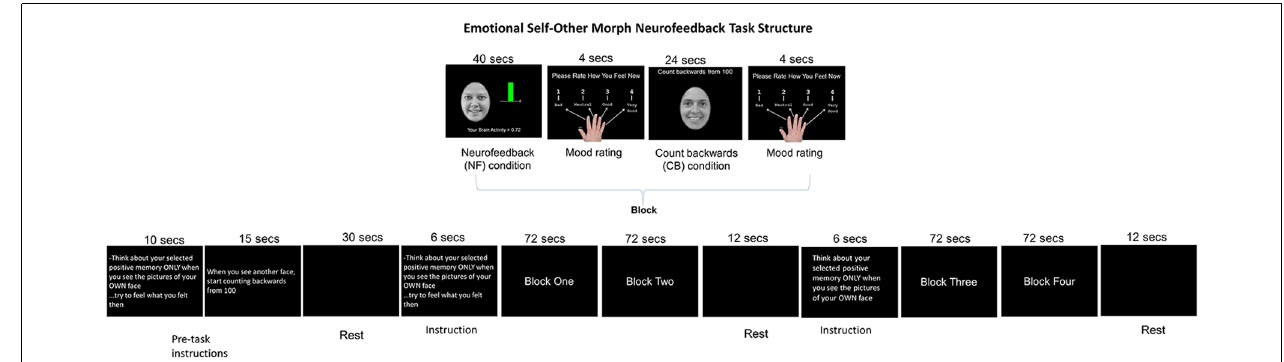
FIGURE 1 | Emotional Self-Other Morph Neurofeedback Task: adolescents recalled happy autobiographical memories during the neurofeedback blocks while seeing their smiling face and counted backward from 100 during the control condition while seeing an unfamiliar face. A shifting colored bar during the neurofeedback blocks was green when the target areas’ activity was above 0 and red for below